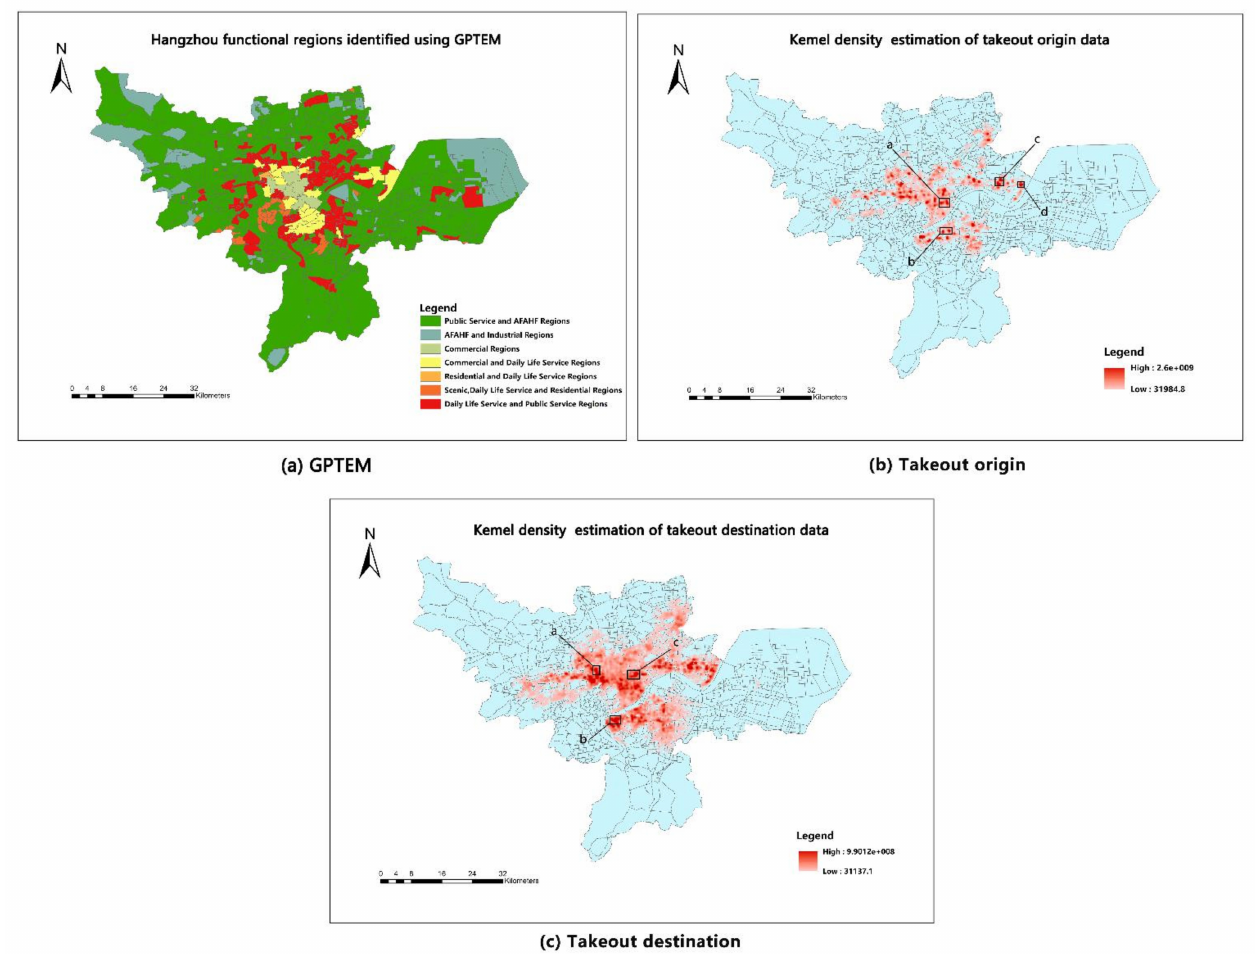
Figure 7. Functional regions identified using GPTEM ( a ) and kernel density estimation of takeout origin ( b ) and destination ( c )